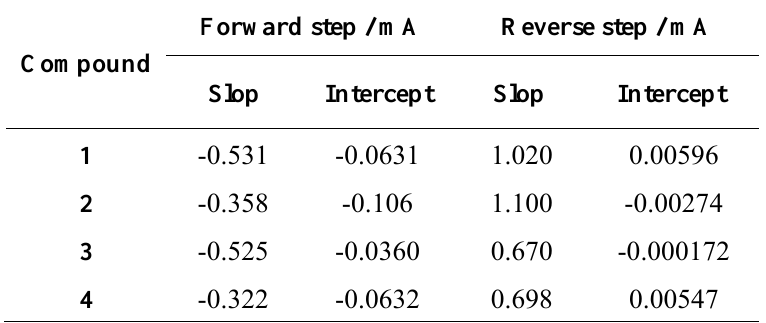
Table 6. The slope and intercept of Cottrell plot for cobalt phthalocyanine